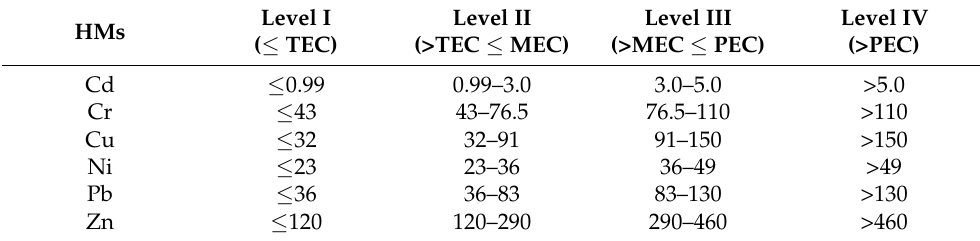
Table 3. Ecotoxicological criteria for assessing the quality of bottom sediments using the Threshold Effect Concentration (TEC), Midpoint Effect Concentration (MEC), and Probable Effect Concentration (PEC) values (mg · kg − 1